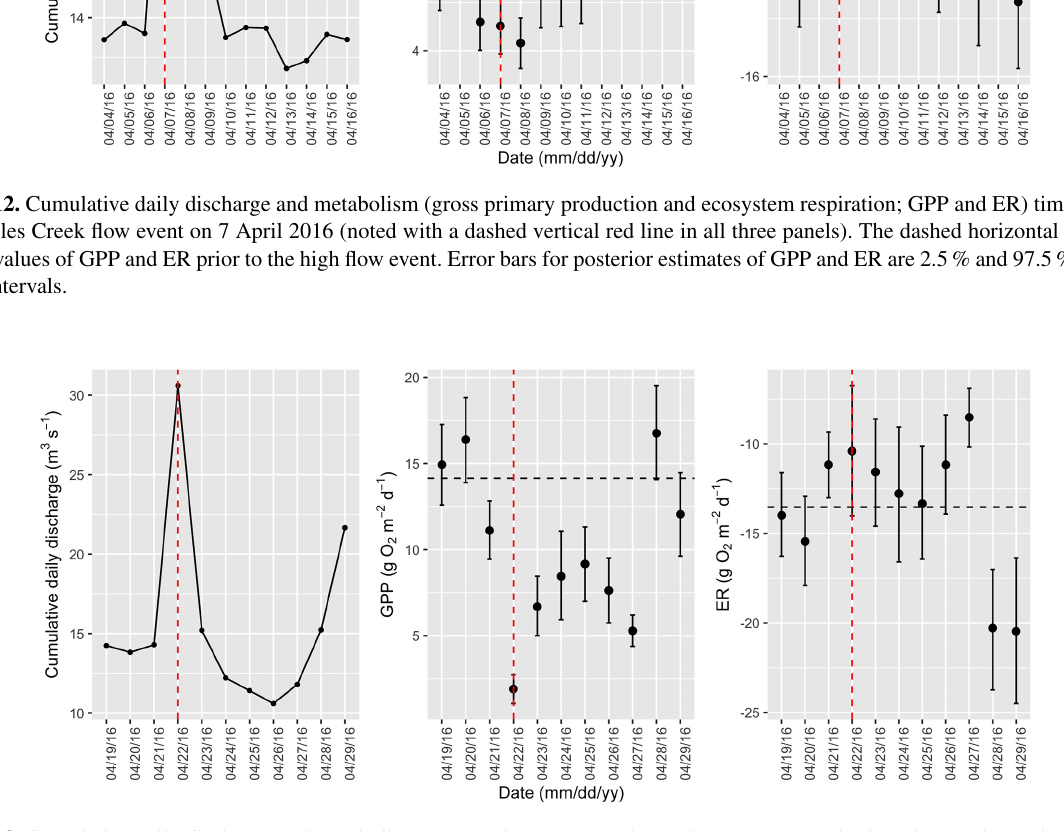
Figure A13. Cumulative daily discharge and metabolism (gross primary production and ecosystem respiration; GPP and ER) time series for the Stroubles Creek flow event on 22 April 2016 (noted with a dashed vertical red line in all three panels). The dashed horizontal black lines are mean values of GPP and ER prior to the high flow event. Error bars for posterior estimates of GPP and ER are 2.5% and 97.5% Bayesian credible